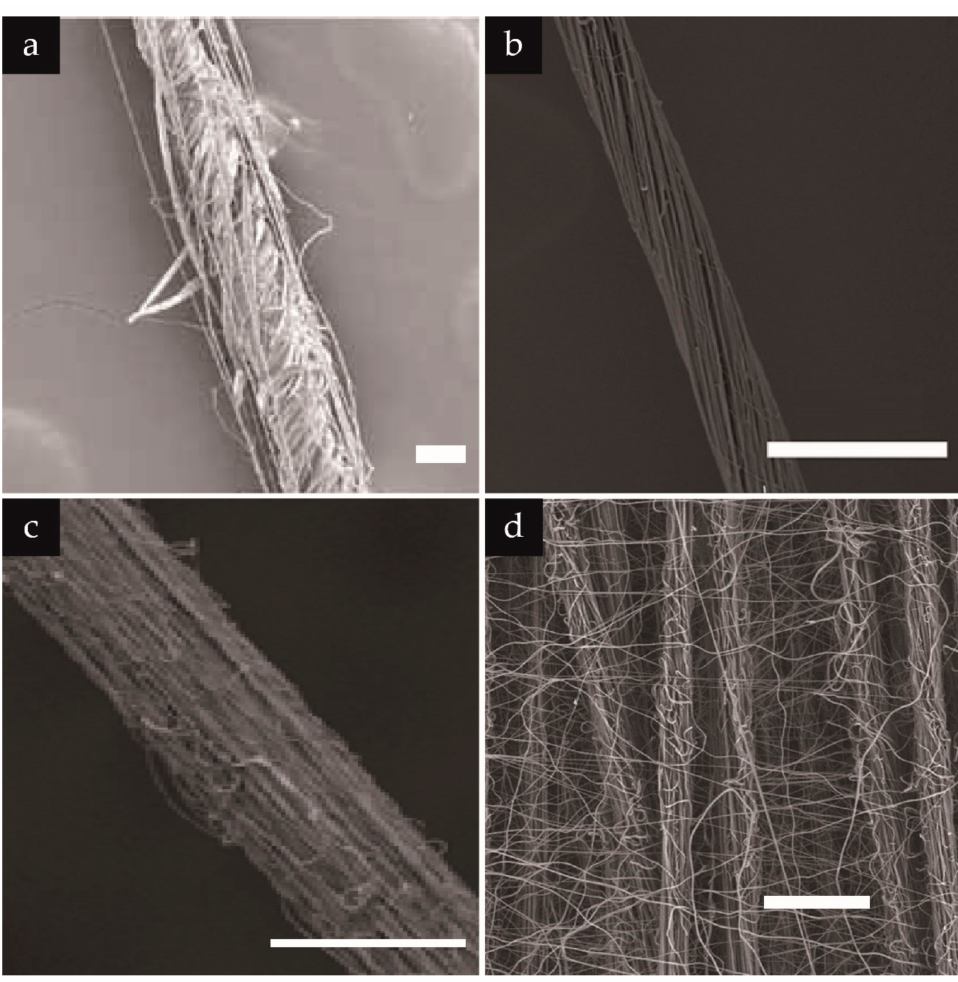
Figure 5. SEM images of electrospun yarns from the works of ( a ) Afifi et al. showing fibers lacking uniformity in alignment. Several fibers were aligned parallel to the yarn axis. Reprinted with permission from Ref. [27]. Copyright 2010 Wiley. ( b ) Li et al. produced yarns with highly aligned fibers. Reprinted with permission from Ref. [28]. Copyright 2020 American Chemical Society. ( c ) Wu et al. spun yarns with no apparent twist. Reprinted with permission from Ref. [30]. Copyright 2013 Elsevier. ( d ) Yang et al. produced a mixture of yarns and randomly aligned fiber mats. Reprinted with permission from Ref. [38]. Copyright 2014 Elsevier. Scale bars = 100 µ